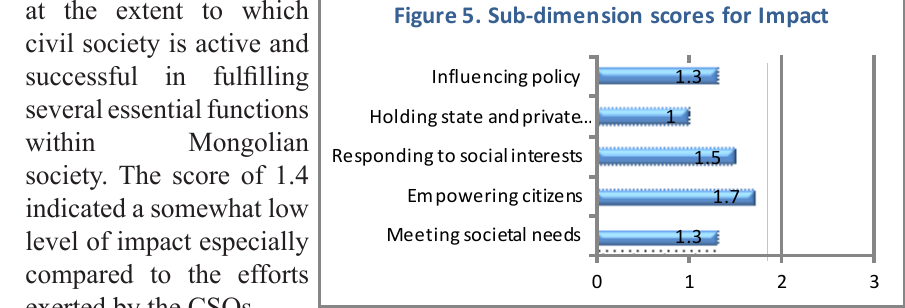
Figure 5. Sub-dimension scores for